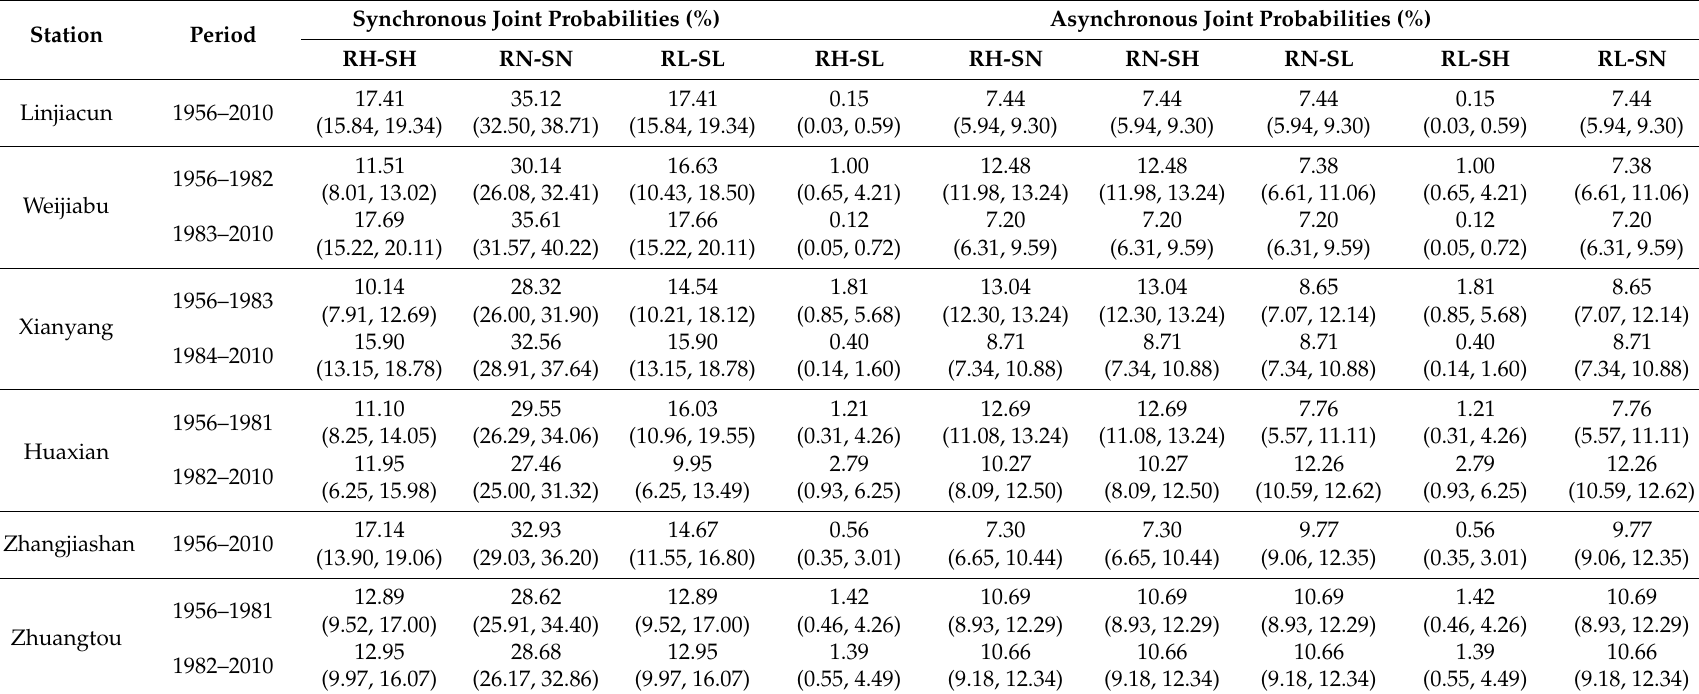
Table 6. Synchronous-asynchronous joint probability of high-low runoff and sediment in the